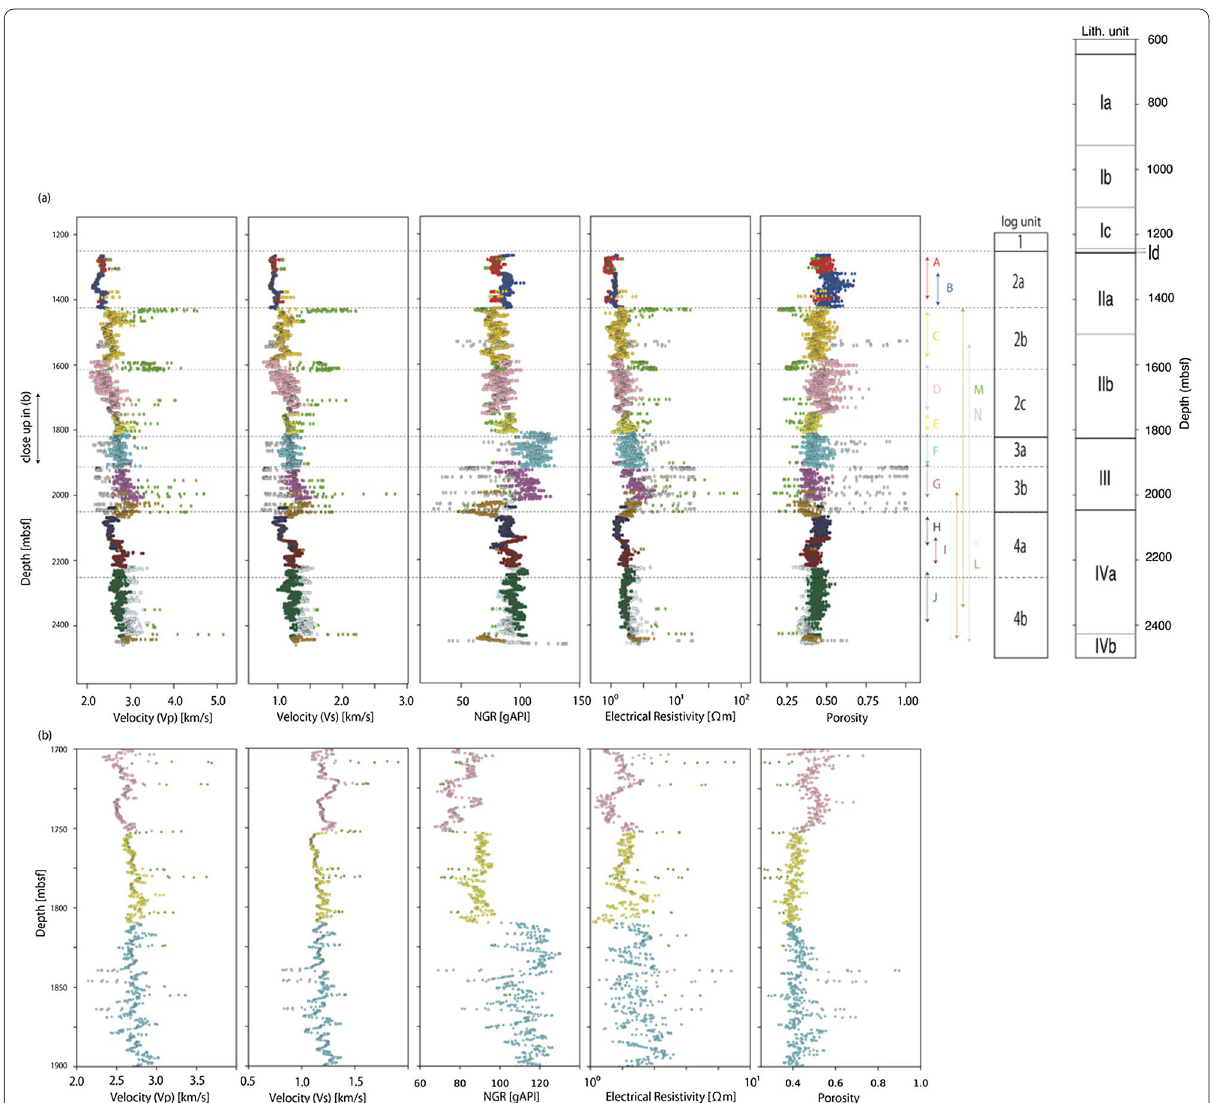
Fig. 12 Clustering results at C0020 in original logging data domain and previously reported log units (Expedition 337 Scientists 2013b). a The entire section, and b the close‑up figure of a where noted by a black arrow on the